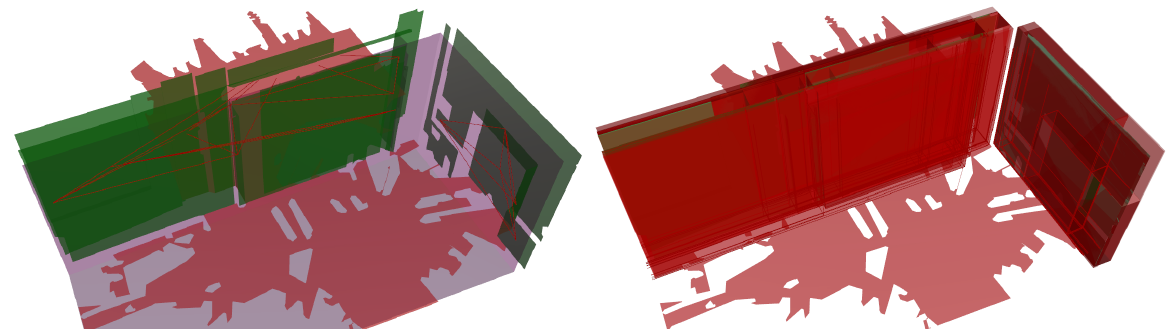
(a) Representation of the fully connected graph based on the eu- clidean distance between nearest neighbors.